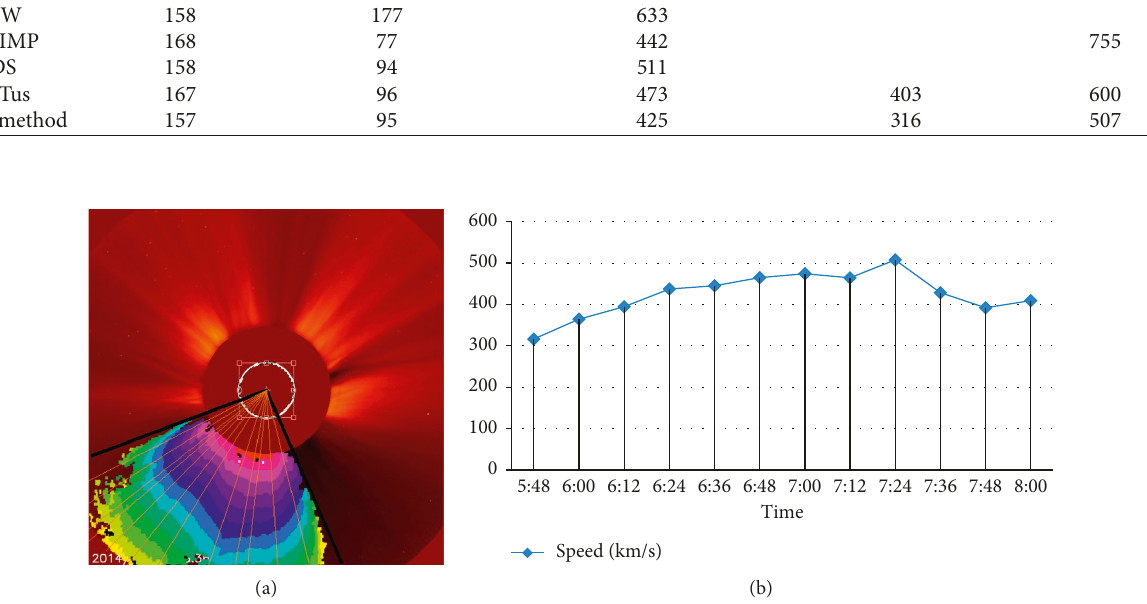
Figure 8: Speed calculation sketch map and speed change curve